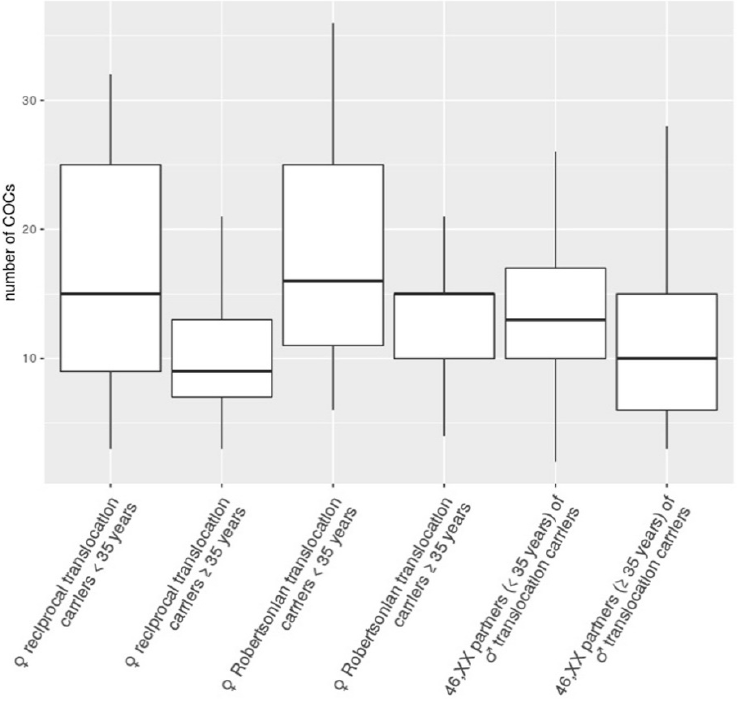
Figure 1. Box plot of the number of cumulus–oocyte complexes (COCs) retrieved after controlled ovarian hyperstimulation in six subgroups of women subcategorized by age (<35 and ≥ 35 years) and presence of a chromosomal rearrangement (female carriers of a Robertsonian translocation, female carriers of a reciprocal translocation and karyotypically normal partners of male transloca- tion carriers). The lower whisker represents the smallest observation greater than or equal to the lower hinge—1.5 × IQR; the lower hinge represents the 25% quantile; the line through the middle region of the box represents the median, 50% quantile; the upper hinge represents the 75% quantile; the upper whisker represents the largest observation less than or equal to the upper hinge + 1.5 × IQR. The inter-group comparison of the medians showed no statistically significant difference (Mood’s median test, chi-squared = 11.054, df = 7, p =